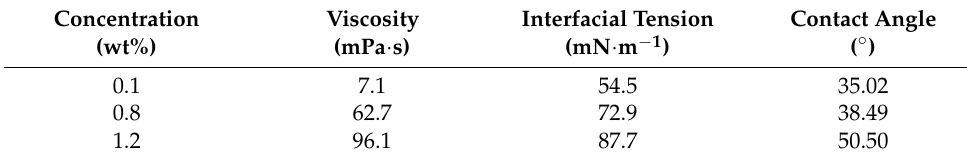
Figure 3. The contact angles of fracturing fl uid-nitrogen and glass surface: ( a ) 0.1 wt% fracturing fl uid; ( b ) 0.8 wt% fracturing fl uid; ( c ) 1.2 wt% fracturing fl uid. Table 3. The properties of the fl uids.